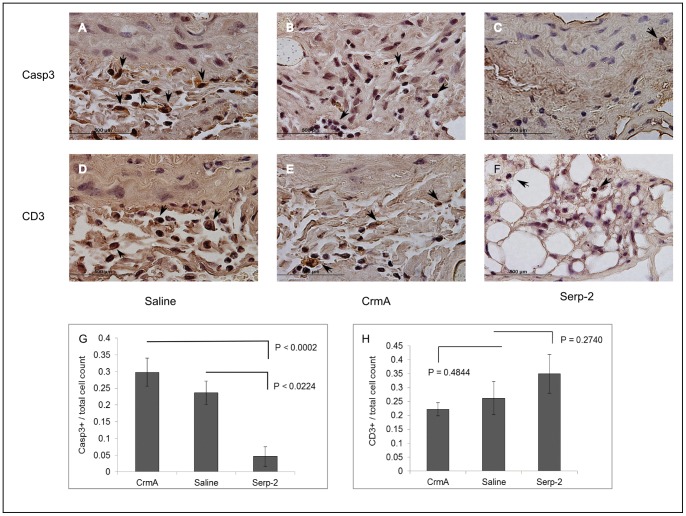
CD3 and active Caspase 3 populations 72 hrs after mouse aortic allograft.C57Bl/6 donor aortic allografts were transplanted into Balb/C recipient mice (N = 3 per treatment) and followed up at 72hrs. Compared to saline, Serp-2 but not CrmA treatment reduced caspase 3 activity (panels A-C,G; p<0.0224). Neither protein treatment significantly reduced CD3+ T cells (panels D-F,H).